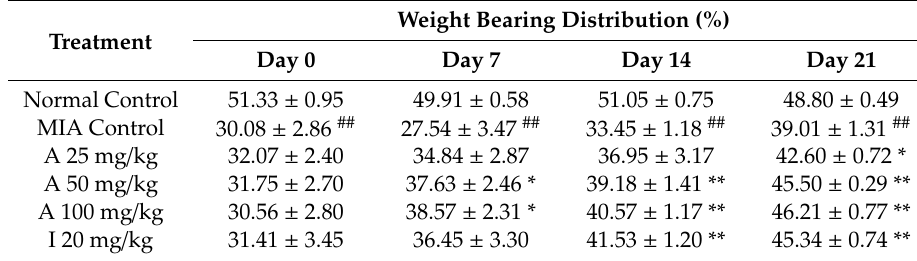
Table 1. E ff ects of AyuFlex ® on weight-bearing distribution in the hind paw for 21 days in MIA-incurred OA in rats. The results are expressed as the mean ± SEM ( n = 8 / group). A, AyuFlex ® ; I, Ibuprofen. * p < 0.05, ** p < 0.01, in comparison with MIA-induced control group; ## p < 0.01, in comparison with the non-MIA induced control group.